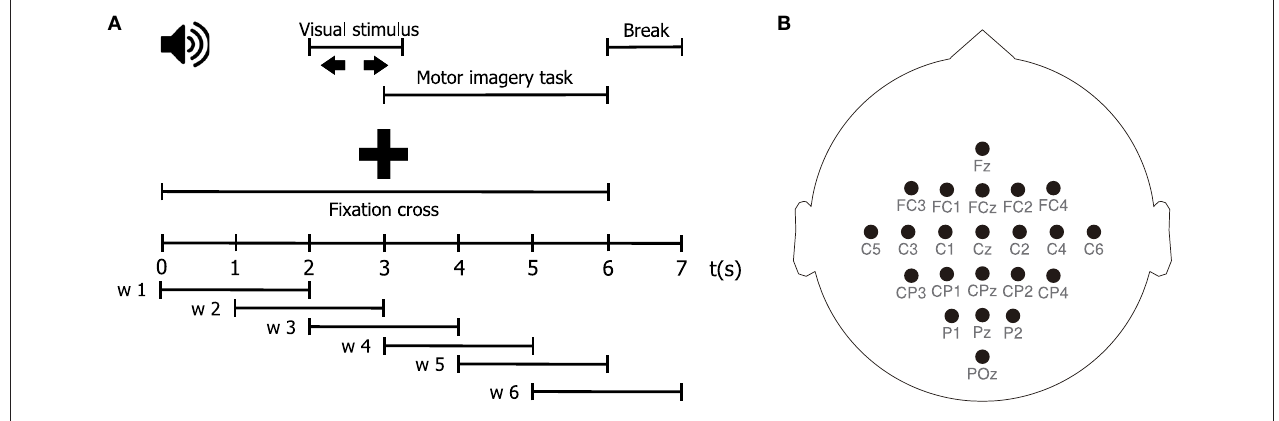
FIGURE 1 | (A) Schematic representation of the MI protocol. (B) EEG channel montage used for the acquisition of the MI